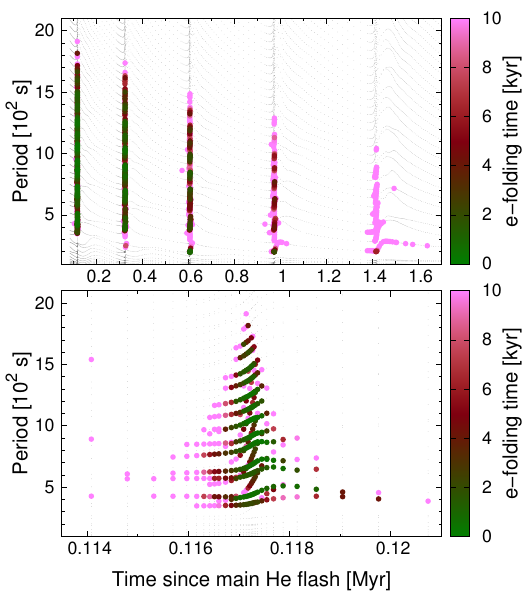
Figure 3. The logarithm of the squared Lamb and Brunt-Väisälä fre- Figure 4. Upper panel: Period vs. time of a sequence with Z = 0.02, quencies (black and red lines) in terms of the outer mass fraction Y = 0.285 and M * = 0.457 M . Excited periods are coloured with ⊙ coordinate. Black points mark the nodes of the radial eigenfunc- the e -folding time in colour coding. Lower panel: Zoomed in the first tions. Upper panel corresponds to a model with log g = 5.12, subflash. log T eff /K = 4.53, M * = 0.4868 M with excited modes, whose ⊙ range of frequencies is shown with a green strip. Lower panel corresponds to a model with log g = 4.25, log T eff /K = 4.35, M * = 0.4908 M ⊙ and no excited modes.